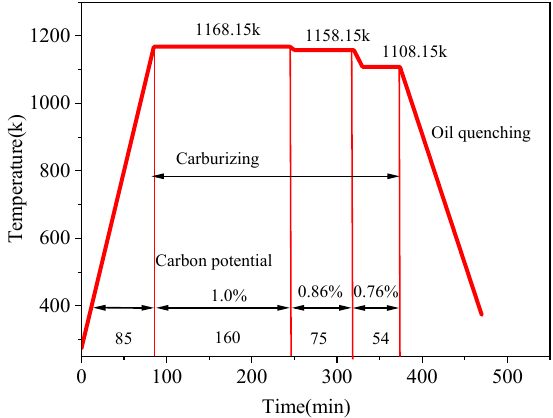
Figure 4. Heat treatment process curve.